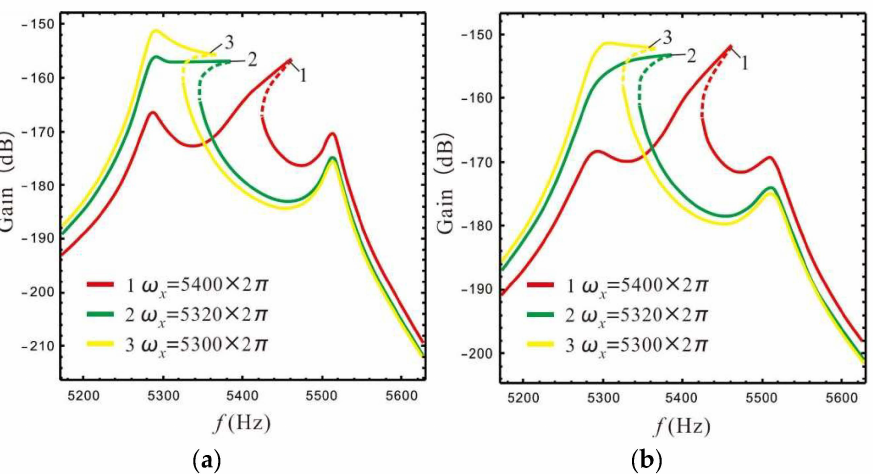
Figure 11. Gain and bandwidth affected by spacing between Coriolis and left peaks: ( a ) B = 1.4, ( b ) B =